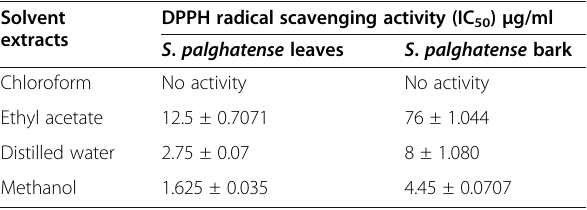
Table 6 DPPH radical reducing activity of different solvent extracts of S . palghatense leaves and bark Solvent extracts